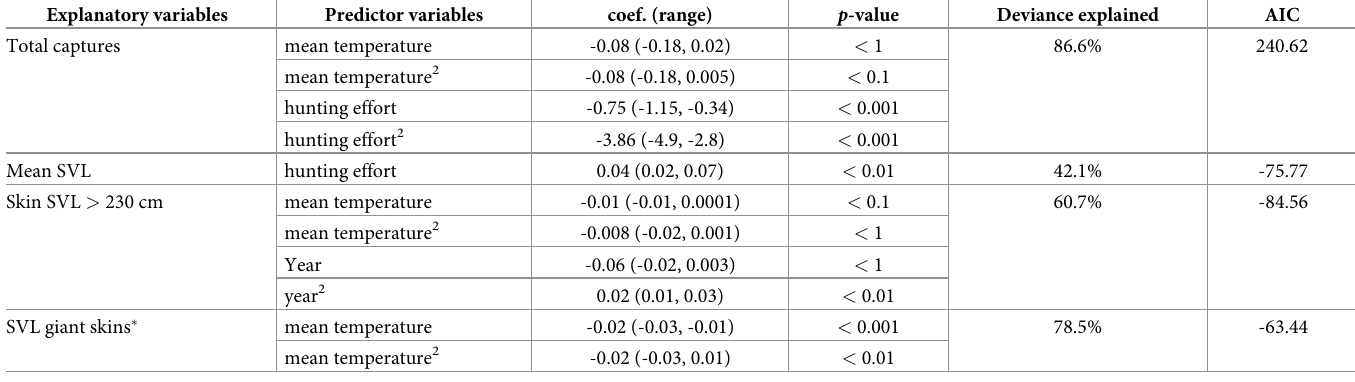
Table 3. Selected GLM-based interaction models for yellow anaconda ( Eunectes notaeus ) harvest parameters measured by the Programa Curiyú between 2004–2019 in northeastern